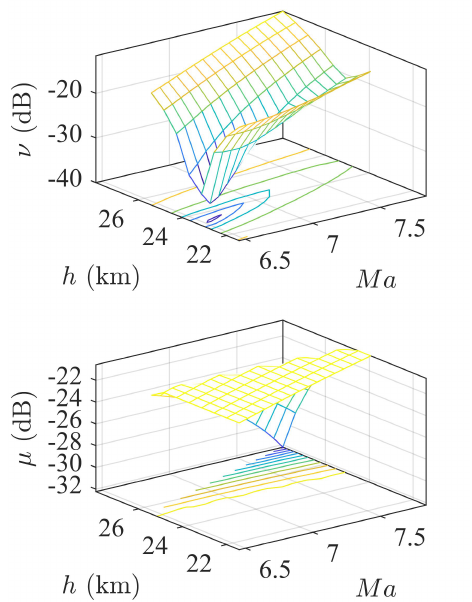
Figure 7. NCSM and gap metric of ascent tracking at Mach 6.5, h = 23,408 m.